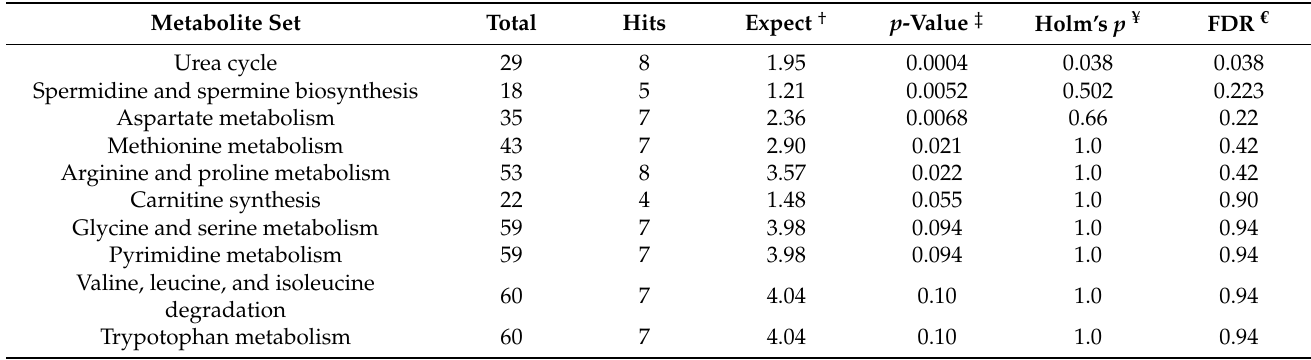
Table 2. Effect of Empagliflozin on discrete metabolite sets * in kidney (top 10 listed). Metabolite Set